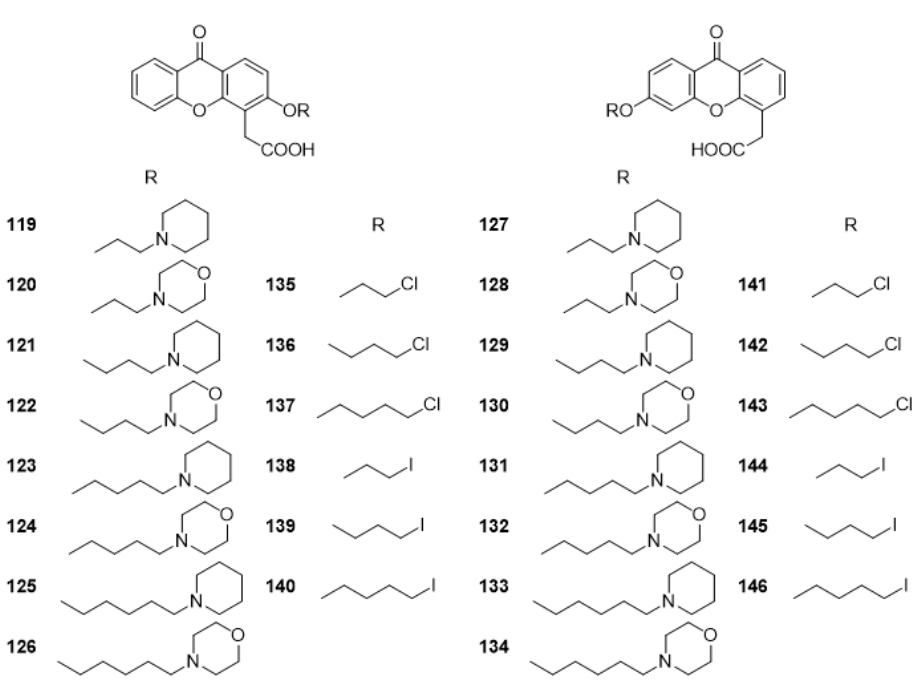
Figure 10. Structure of DMXAA analogues 119 – 146 .